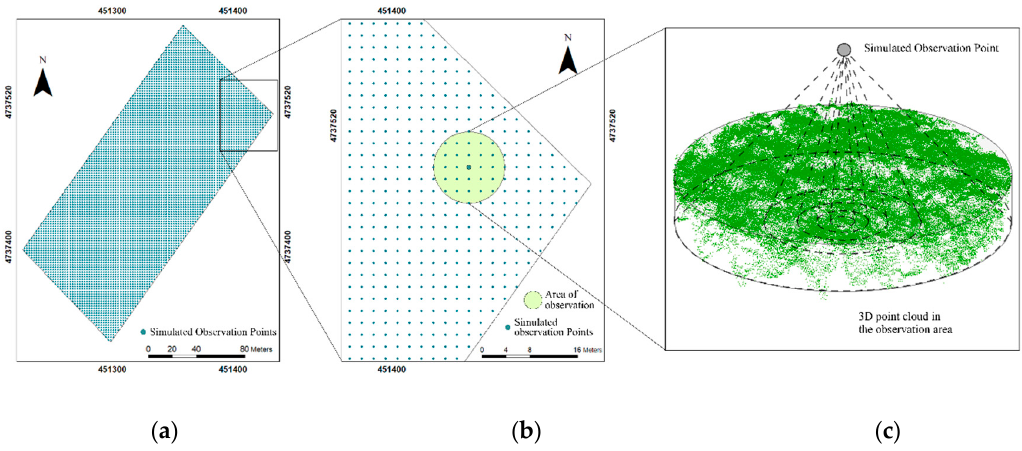
Figure 3. The general principle of Simulated Observation of Point Cloud (SOPC) method for point observation [47]. ( a ) The simulate observation points in the study area; ( b ) the observation area for one simulate observation point; ( c ) the 3D respective view of the unmanned aerial vehicle (UAV)-based point cloud data within the observation area.